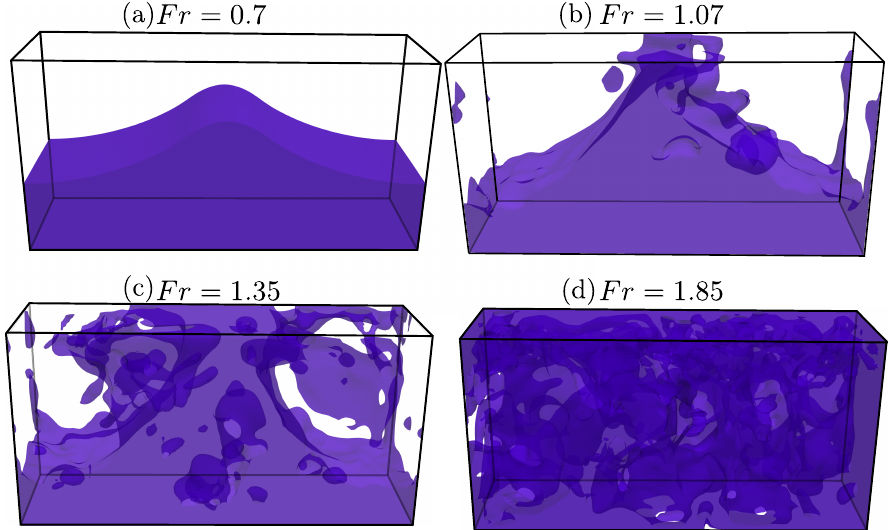
Figure 4. Snapshots of the liquid sloshing at different Fr numbers, ( a ) Fr = 0.7, ( b ) Fr = 1.07, ( c ) Fr = 1.35 and ( d ) Fr = 1.85. The opacity is reduced to 50% to show the internal